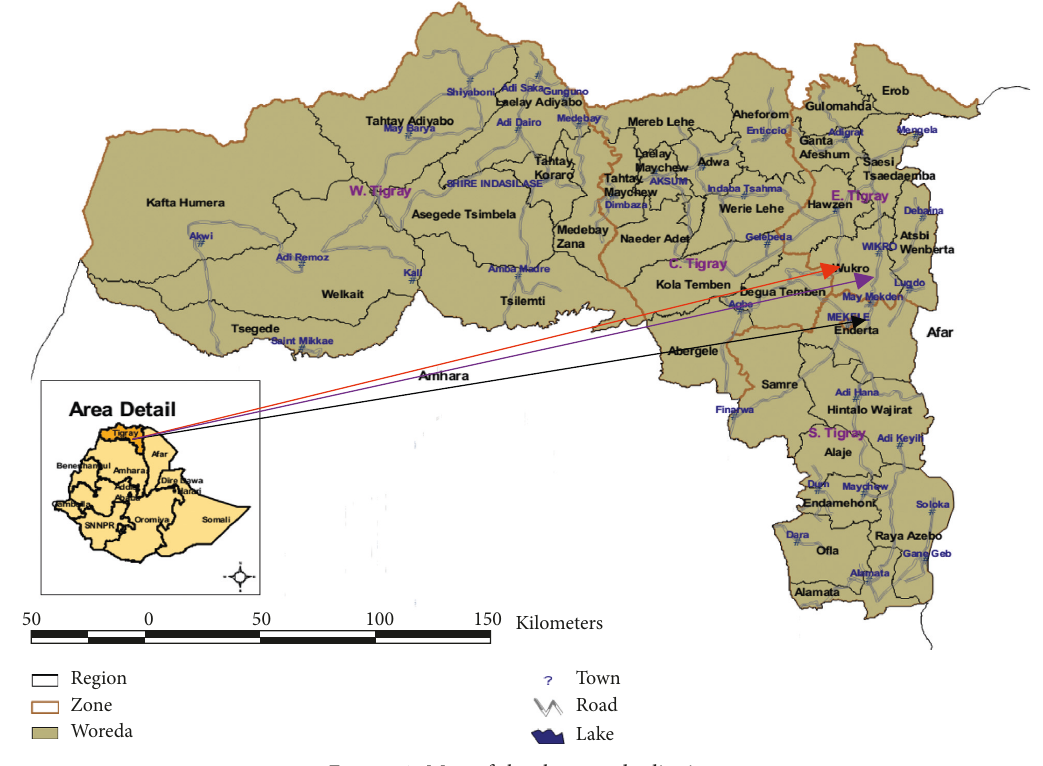
Figure 1: Map of the three study Table 1: Summary of the geolocation of the three study areas. Mekelle Agula Wukro